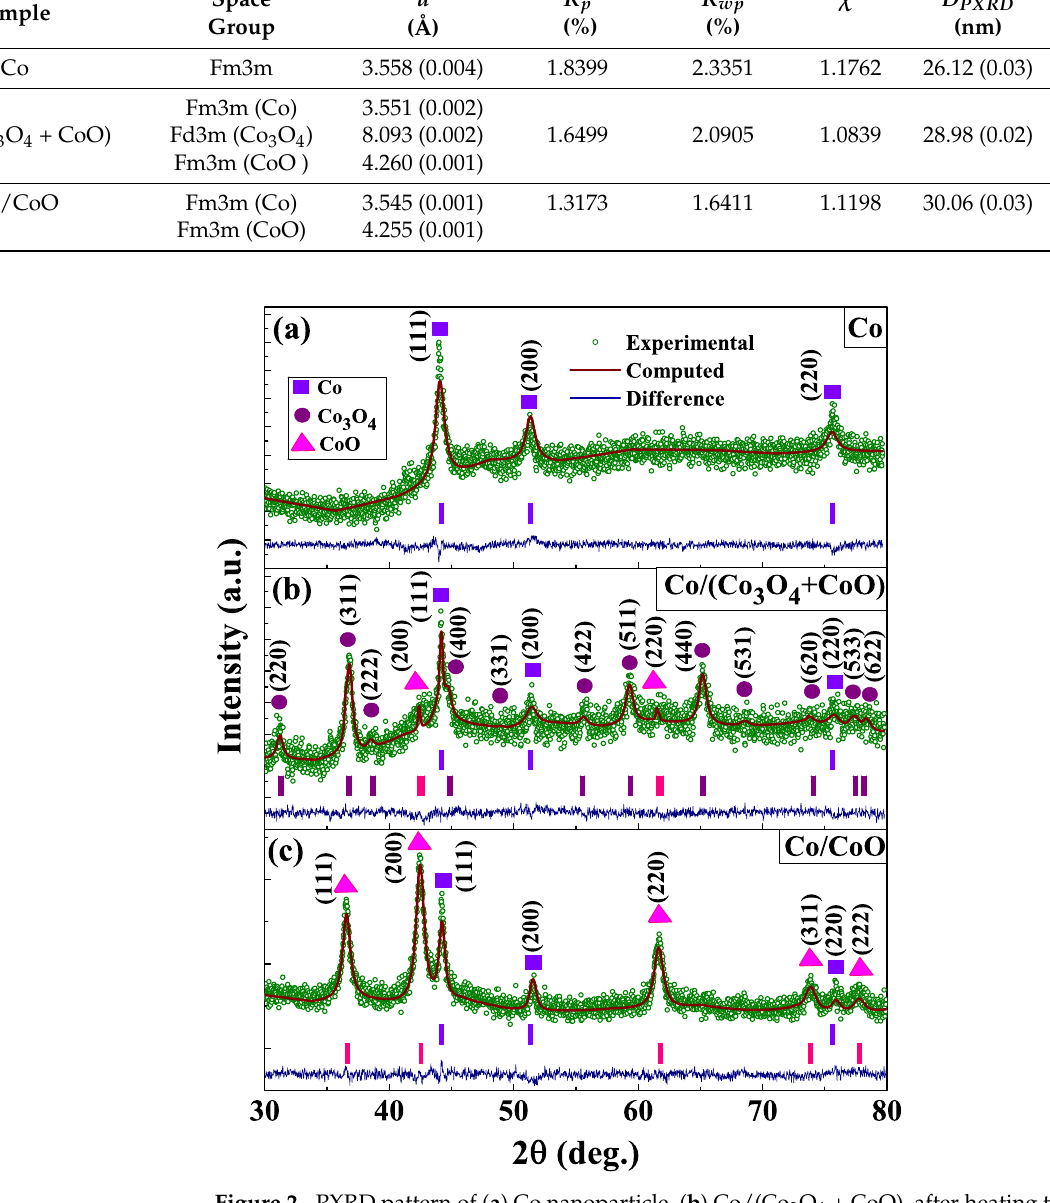
Figure 2. PXRD pattern of ( a ) Co nanoparticle, ( b ) Co/(Co 3 O 4 + CoO), after heating the Co nanopar- ticle in open air and ( c ) Co/CoO core/shell structure. Solid continuous curves are the fits using Rietveld refinement and the lowermost plots in each panel are the residuals. Vertical bars correspond to the peak positions of the different crystalline